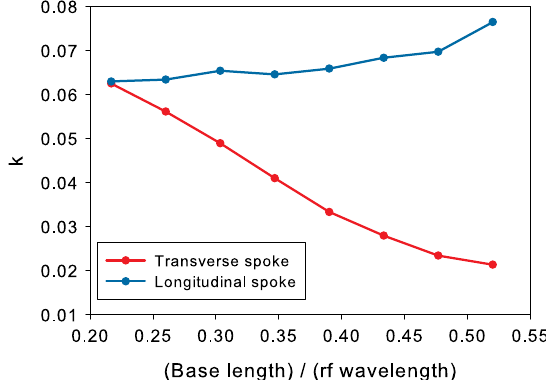
FIG. 38. Coupling k between cells of an optimized (cid:1) 0 ¼ 0 : 82 , 325 MHz two-spoke cavity. The leftmost point is common to both curves since it represents a cylindrical spoke